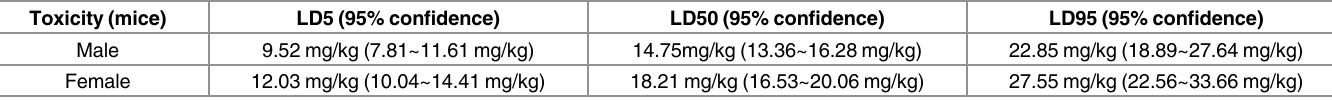
Table 1. Acute toxicity of BF211 in mice. Toxicity